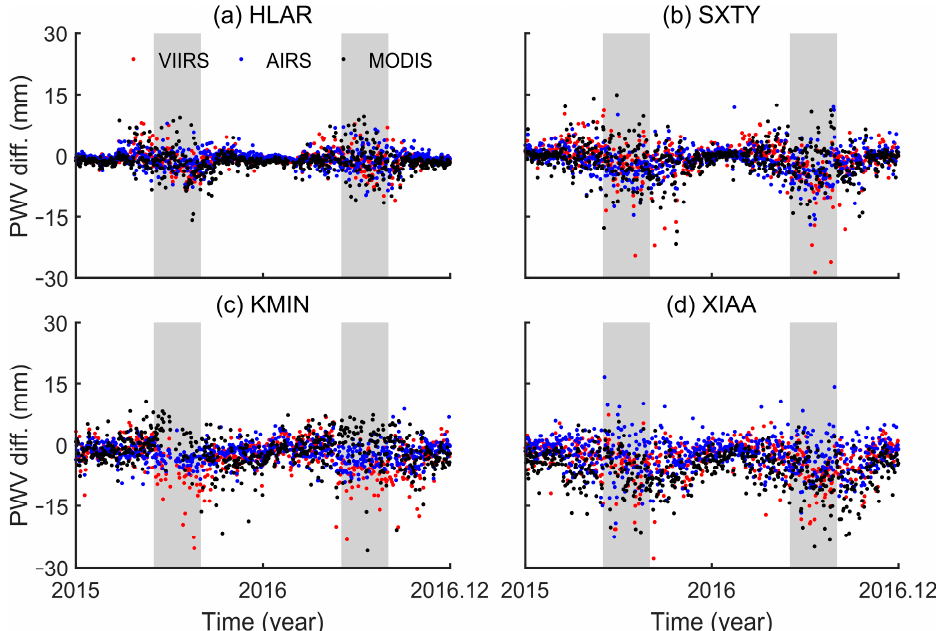
Figure 6. The time series of the PWV differences between the PWV data derived from three remotely sensed water vapor products and the GPS observations at HLAR ( a ), SXTY ( b ), KMIN ( c ), and XIAA ( d ) stations from 2015 to 2016. The grey areas in Figure 6 represent the periods of summer for each year.